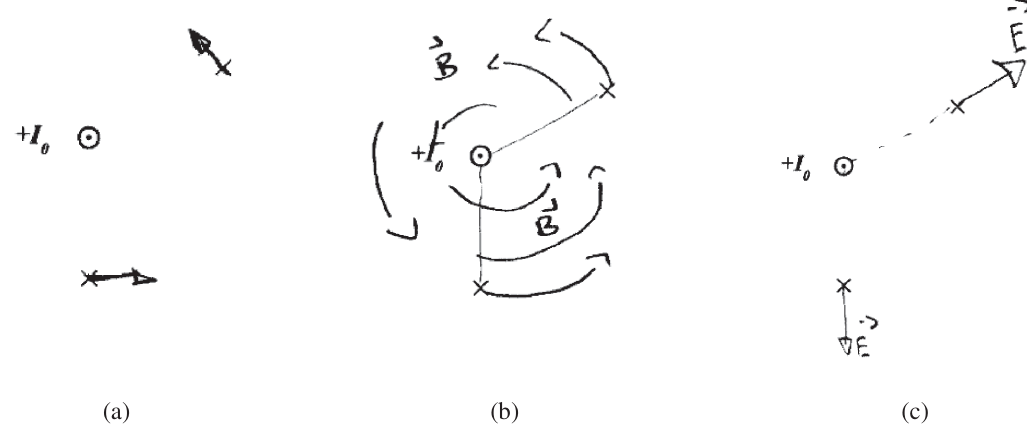
FIG. 4. Examples of the drawings that students made in the first question of the magnetism version. (a) An example of the drawing category vector diagram. (b) An example of the drawing category hybrid of vectors and field lines. (c) An example of the drawing category confusion between electric and magnetic